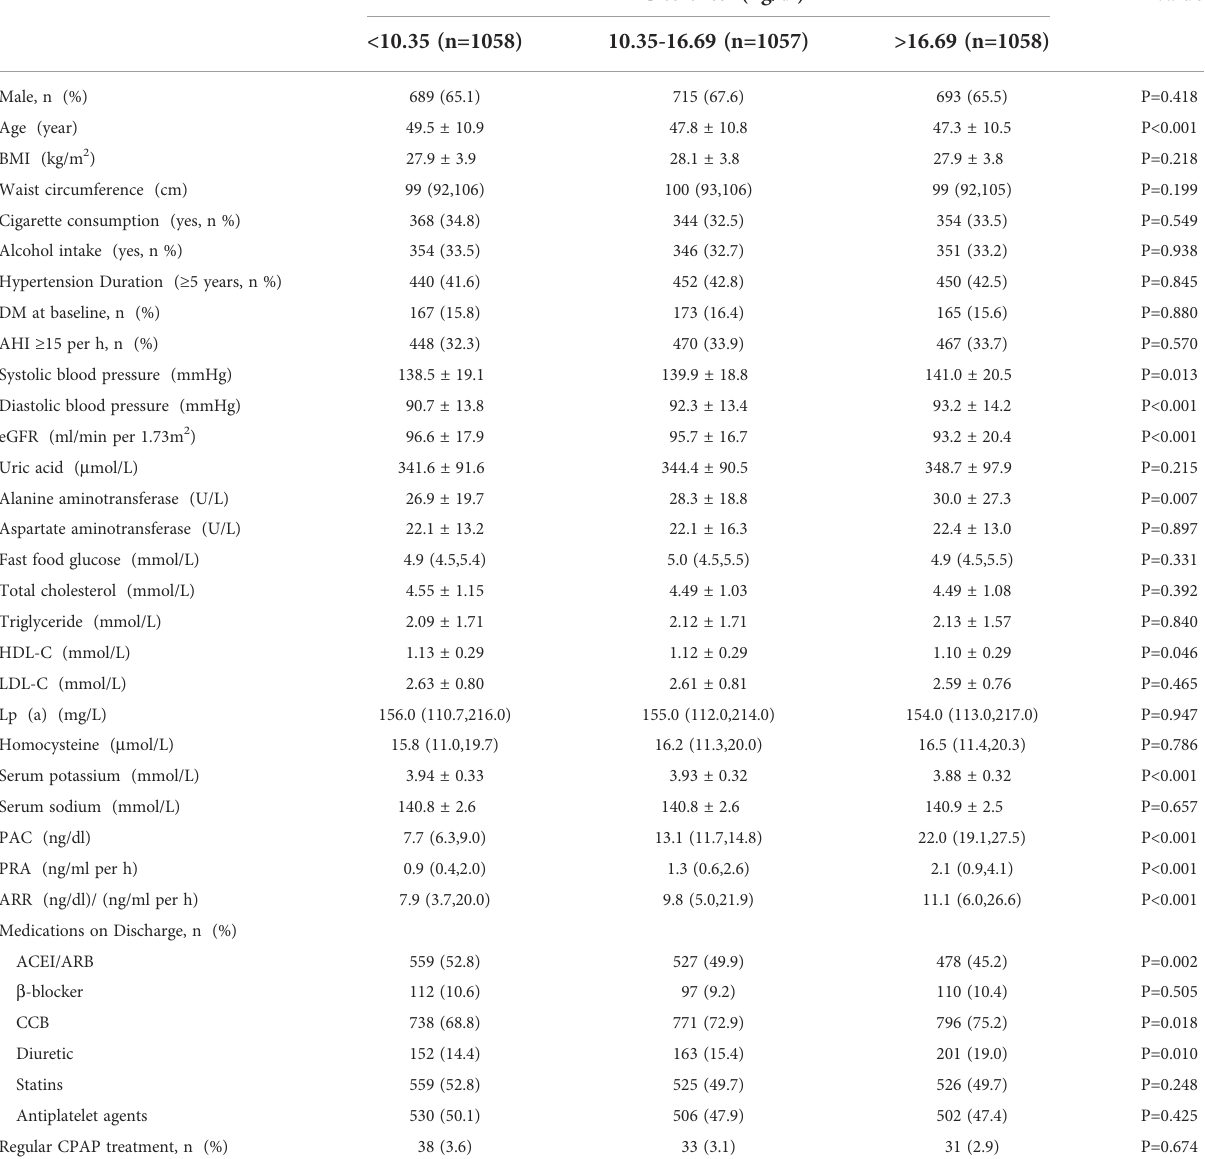
TABLE 1 Baseline characteristics of groups classi fi ed by PAC